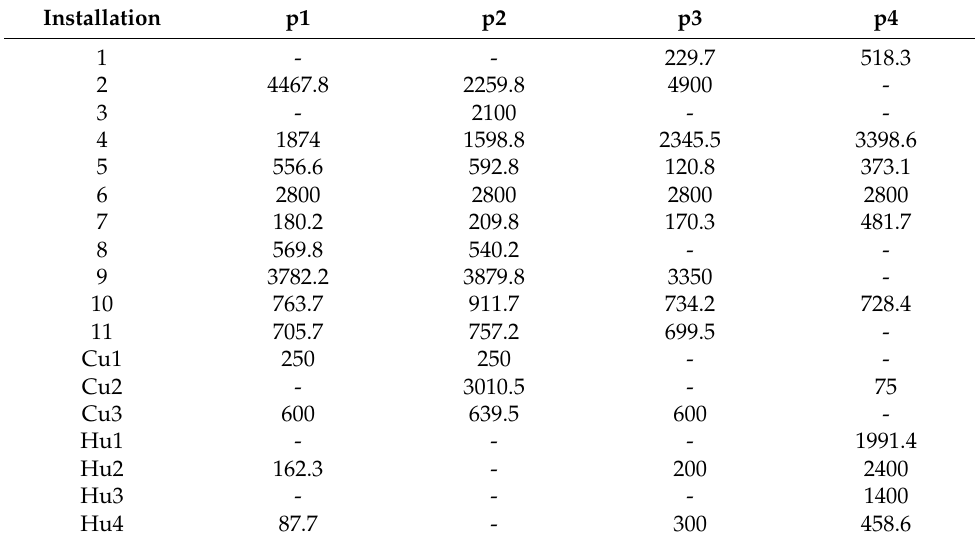
Table 9. Heat Flows without HP and ST case 3